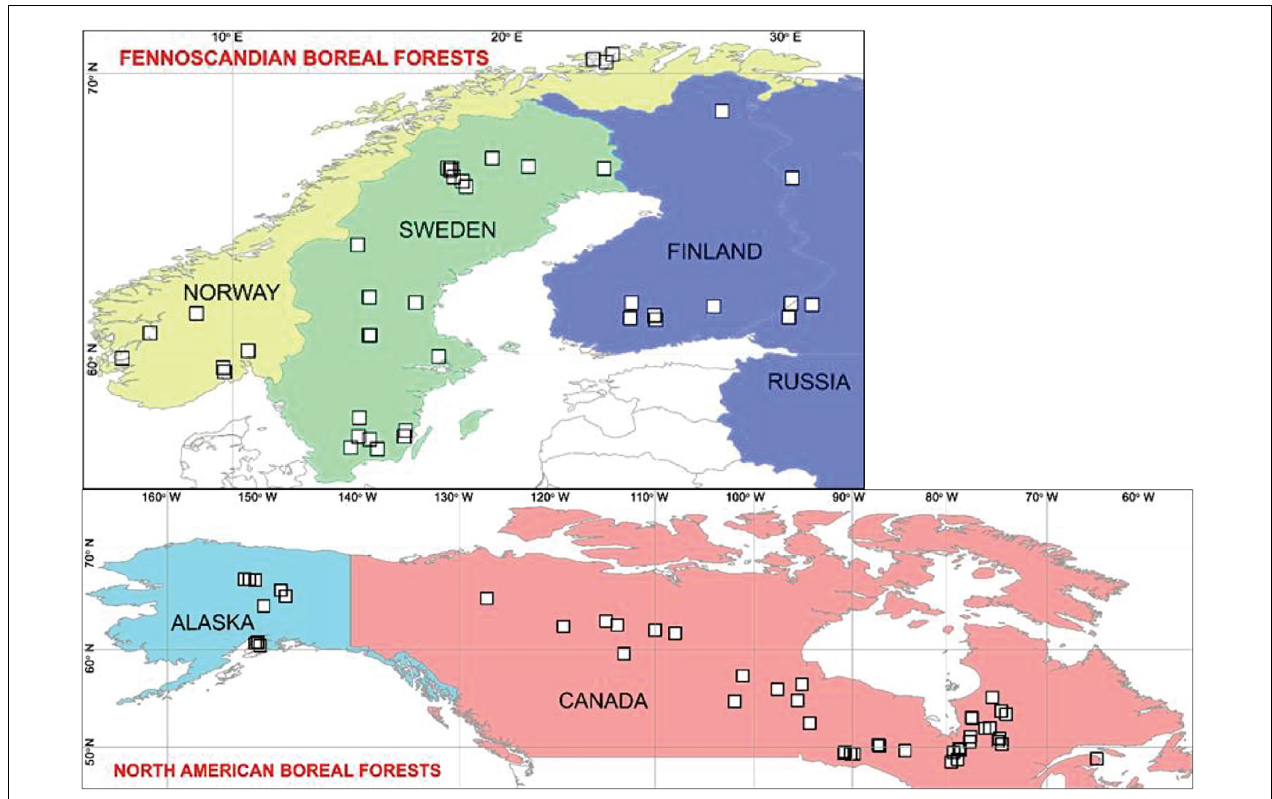
FIGURE 1 | Location map of the selected charcoal records divided into the different continental and regional sub-areas identified for the present study. For the same sites the probability of a grid-cell to burn per year (Fp) and the total carbon flux emitted to the atmosphere per year (Ce) were simulated by LPJ-GUESS-